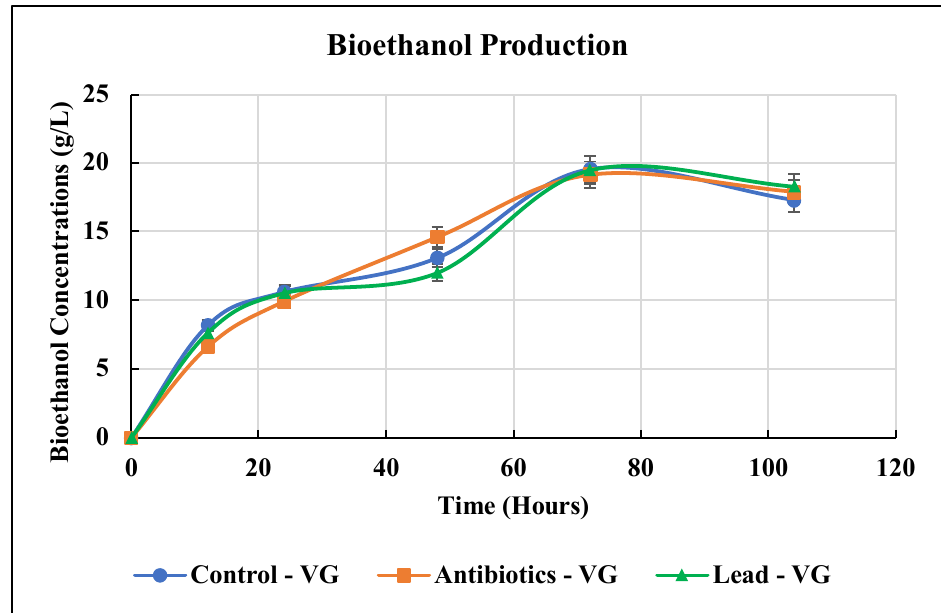
Figure 4. Bioethanol production from different sources of VG. Table 2. Comparison of bioethanol yield of VG and other C4 grasses previously